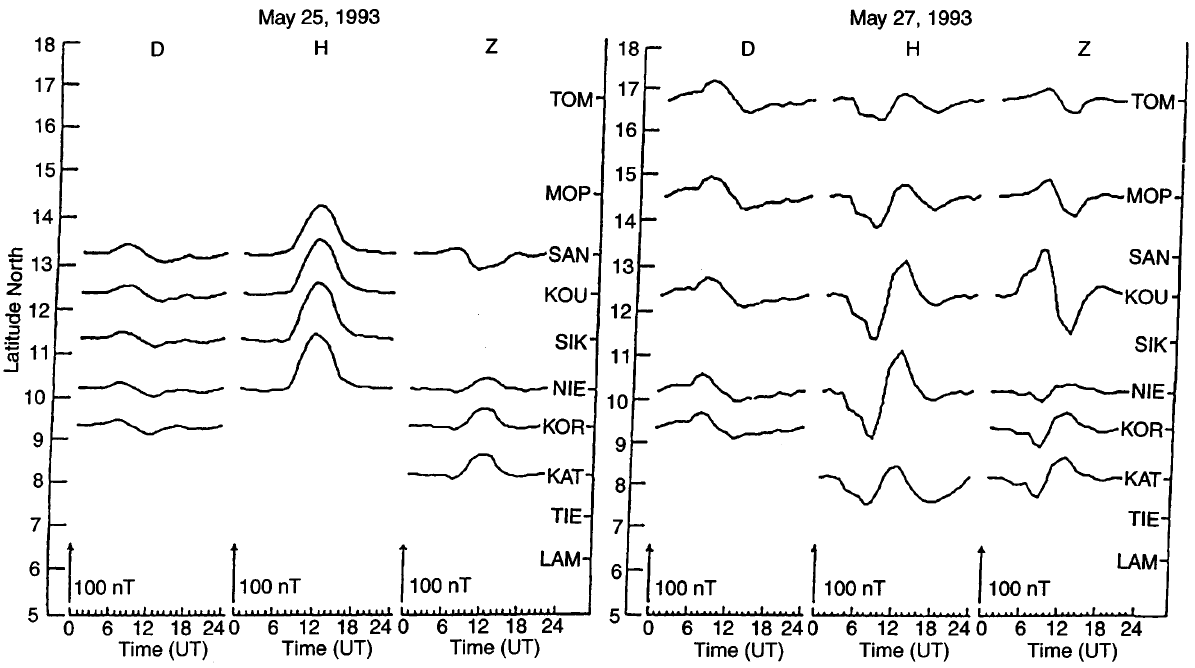
Fig. 2. Latitude profile of D -, H - and Z -components (hourly means) recorded on the West African magnetic network on 25 May 1993 (the reference quiet day) on the left and 27 May 1993 on the